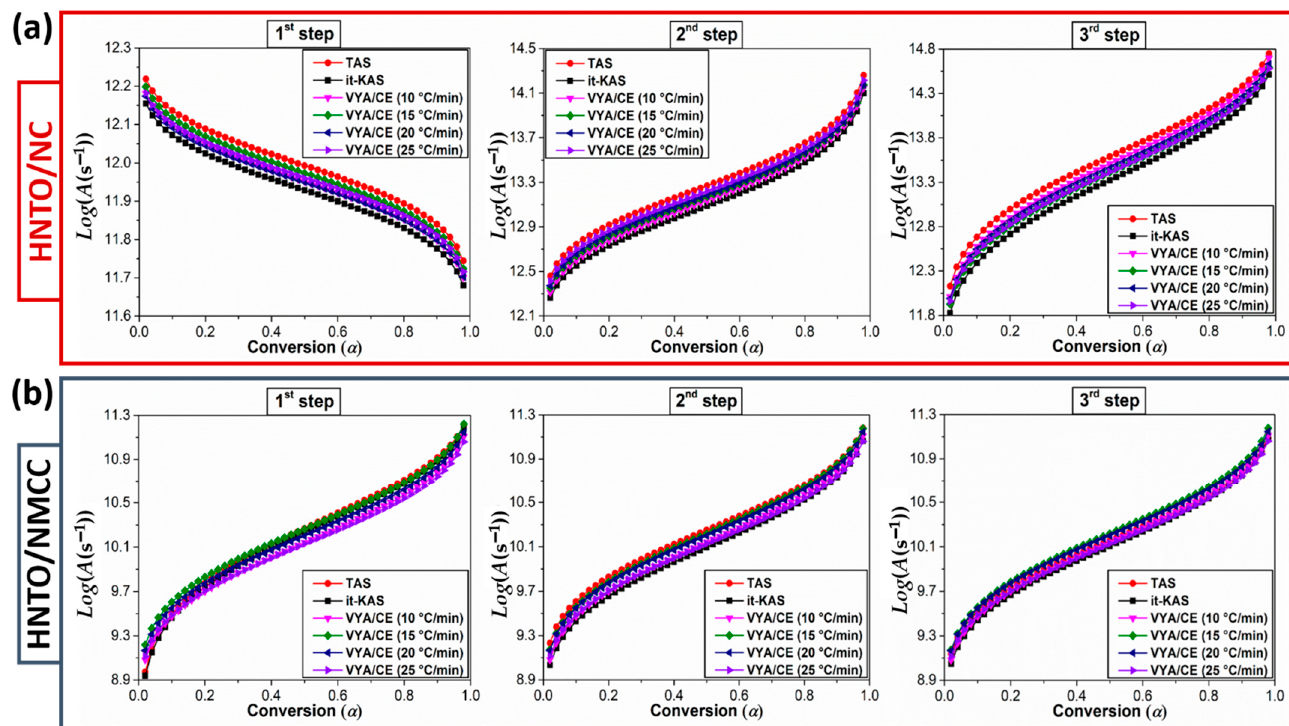
Figure 6. Variation of the decimal logarithm of the pre-exponential factor versus the extent of conversion for each decomposition step of ( a ) HNTO/NC composite; ( b ) HNTO/NMCC composite.